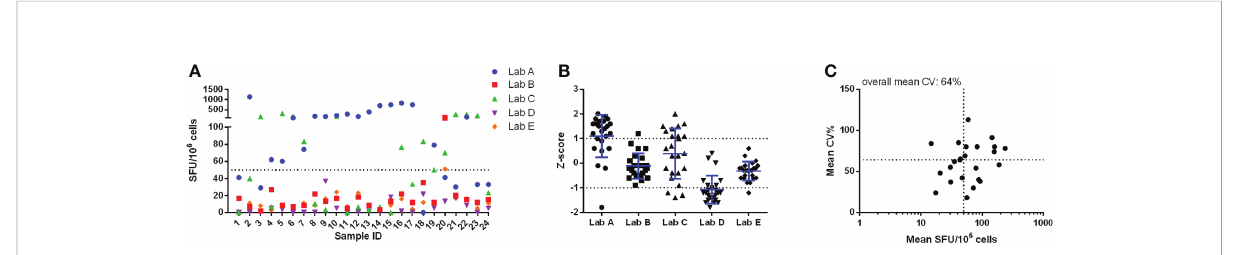
FIGURE 1 Pilot study 1 - unstimulated conditions. Results from each of the 24 samples reported by the 5 labs are given in panel (A) and are expressed as SFU/10 6 cells. The performance of the 5 labs is shown in panel (B) and is expressed as Z-scores. Panel (C) shows the imprecision, expressed as CV%, for the within-sample mean values, expressed as SFU/10 6 cells. Here the horizontal dotted line represents the overall mean CV observed (64%) and the vertical dotted line indicates the arbitrary acceptance criterion of 50 SFU/10 6 cells. Calculations for data shown in panels (B) and (C) were performed with log-transformed